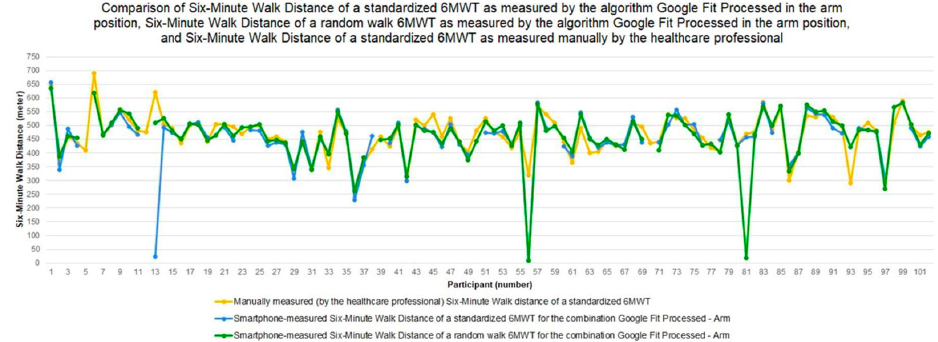
Figure 6. Six-minute walk distance for both the standardized 6MWT and the random walk 6MWT as measured by the algorithm Google Fit Processed with the smartphone in the arm position and for the standardized 6MWT as measured manually by the healthcare professional.